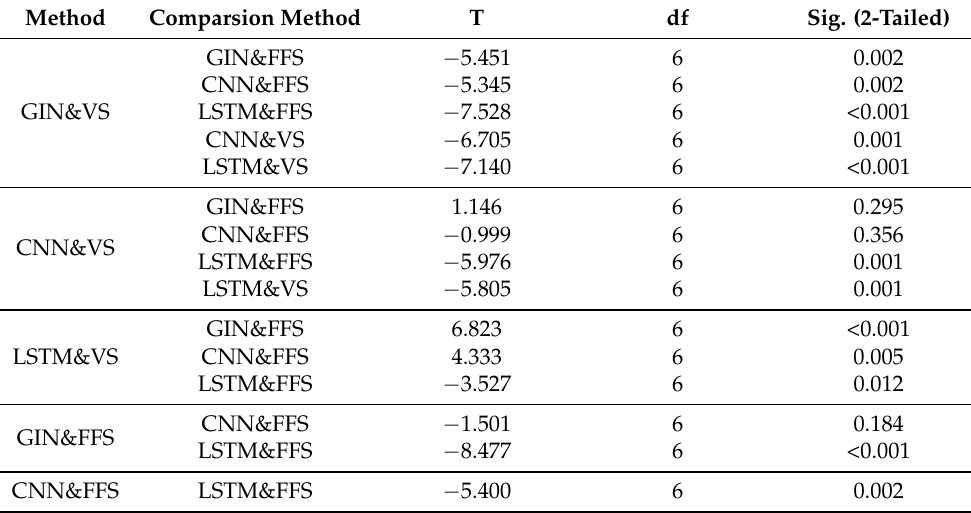
Figure 4. The number of parameters and running times for different models. Table 3. Paired-sample t -test results of different